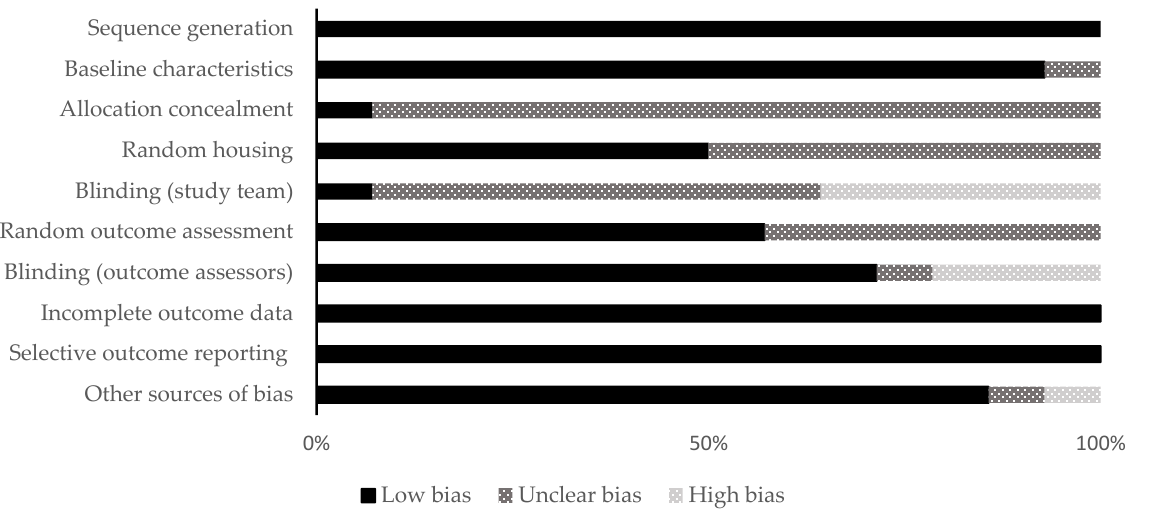
Figure 2. Quality and risk of bias assessment scores of the animal studies using the SYRCLE’s tool.